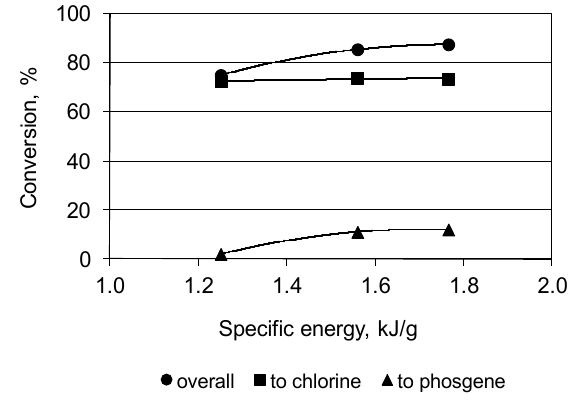
conversion and specific 4